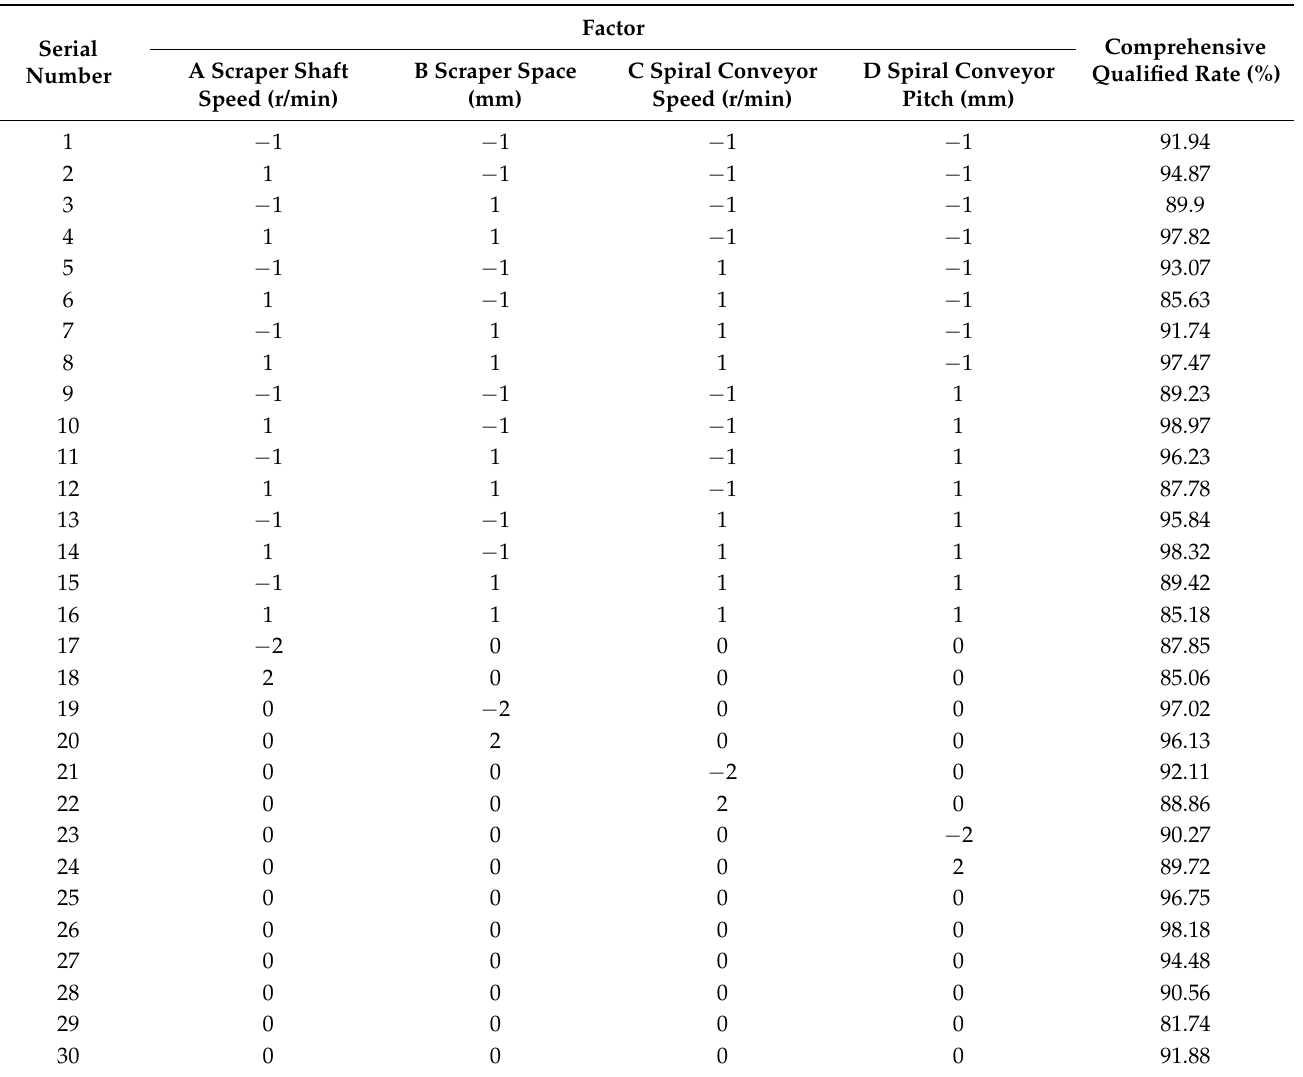
Table 6. Design scheme and result of the